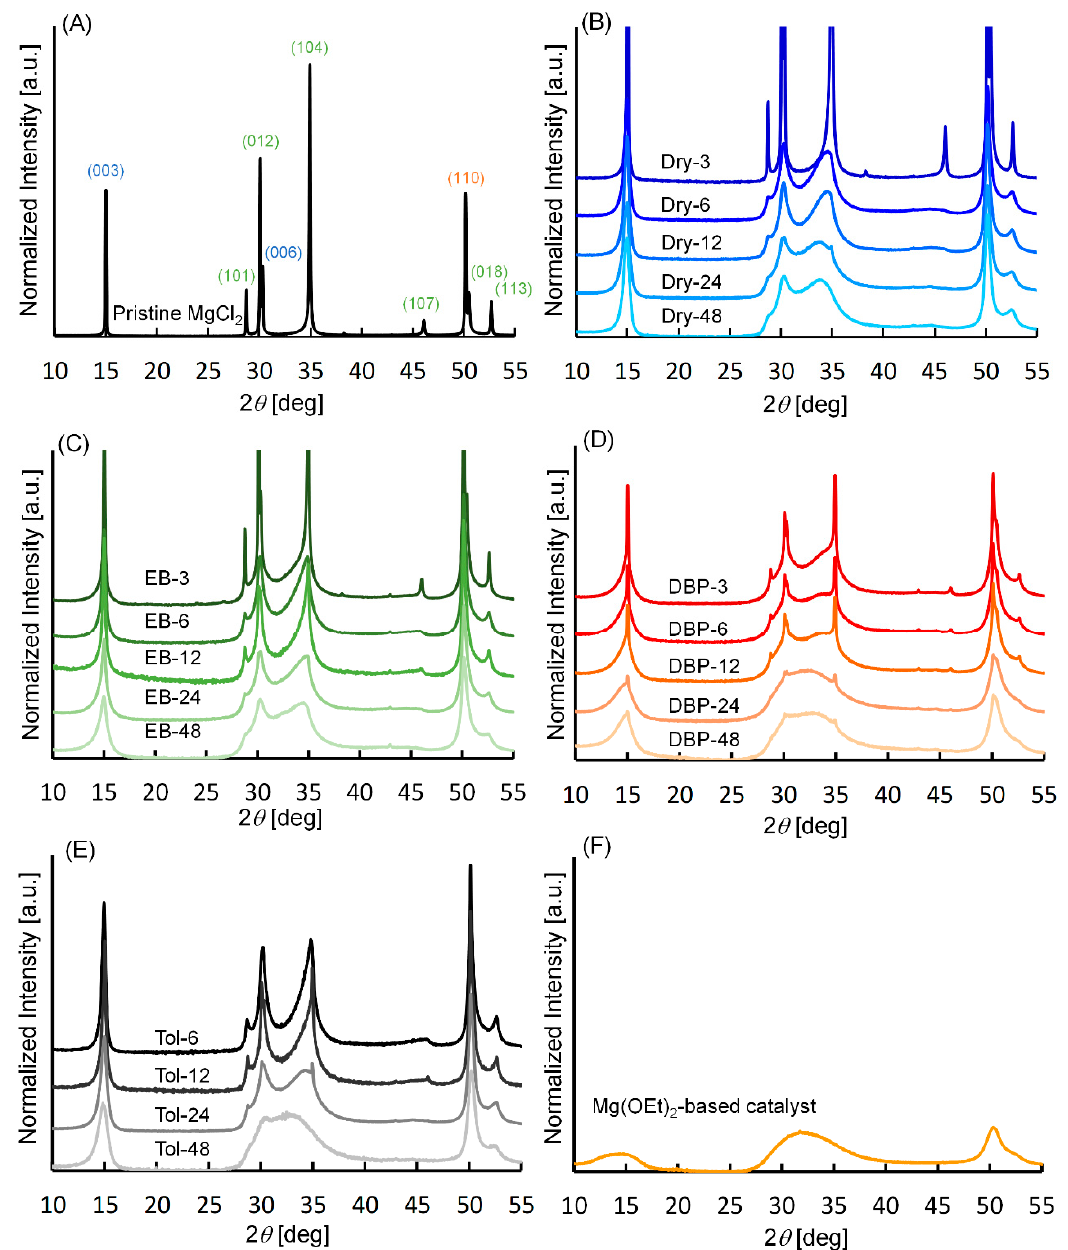
Figure 1. Powder X-ray diffraction (PXRD) patterns of mechanically activated MgCl 2 samples. ( A ) Pristine MgCl 2 . ( B ) MgCl 2 samples ball-milled in a dry condition without adding organic additives. MgCl 2 samples ball-milled with ( C ) EB, ( D ) DBP, and ( E ) toluene. Dry-xx, EB-xx, DBP-xx, and